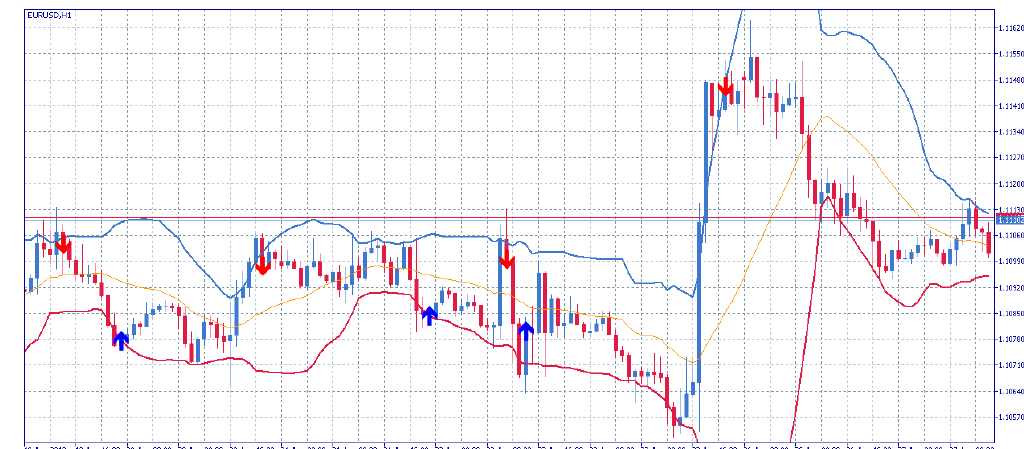
Figure A10. EUR/USD chart with signals from the AdBBAntiTrend strategy